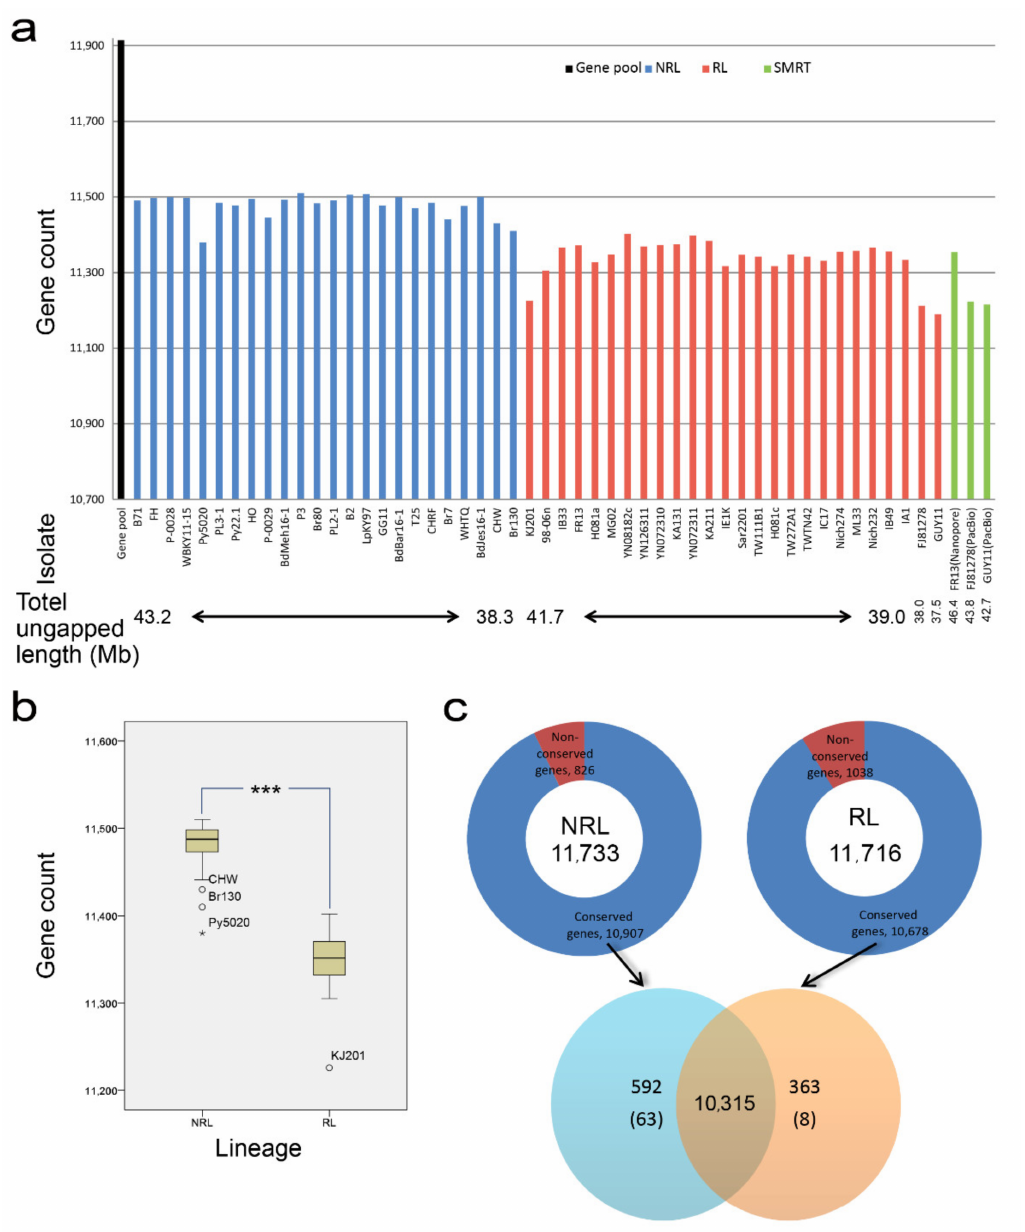
Figure 4. Gene pool analysis. ( a ) The distribution of the genes in gene pool shared in each isolate of RL and NRL. The black, blue, red, and green columns represent the number of genes in the gene pool, isolates of RL, isolates of NRL, and 3 rice-infecting genomes by SMRT, respectively. ( b ) Boxplot of the genes in RL and NRL. The symbol (cid:70) indicated Py5020 in NRL with the extreme value of number of genes. However, Py5020 contained more genes than 87.5% rice-infecting isolates. The symbol ◦ represented the outliers CHW and Br130 in NRL, which also contained higher number of genes than all isolates of RL except YN08182c. ***, p < 0.001 by Student’s t -test. ( c ) The numbers of homologous and non-homologous genes within the group, as well as common genes shared between groups and grouping-specific genes. The number in the intersection of the two solid circles represented the common genes shared in all 48 isolates. Combination 592(63) indicated that 592 genes were common in NRL but absent in at least one isolate of RL, and 63 genes only appeared in all isolates of NRL. 363(8) indicated that 363 genes were common in RL but absent in at least one isolate of NRL, and 8 genes only appeared in all isolates of